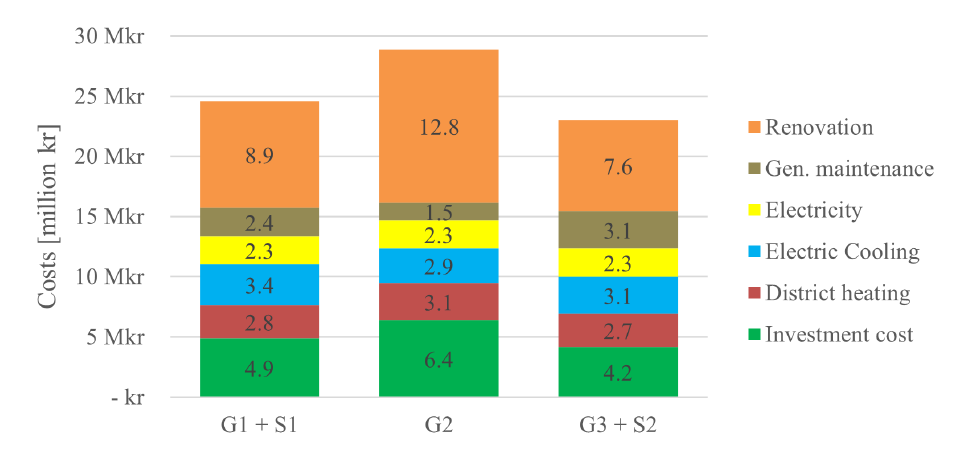
Figure 4. Graphical representation of all the present values and resulting